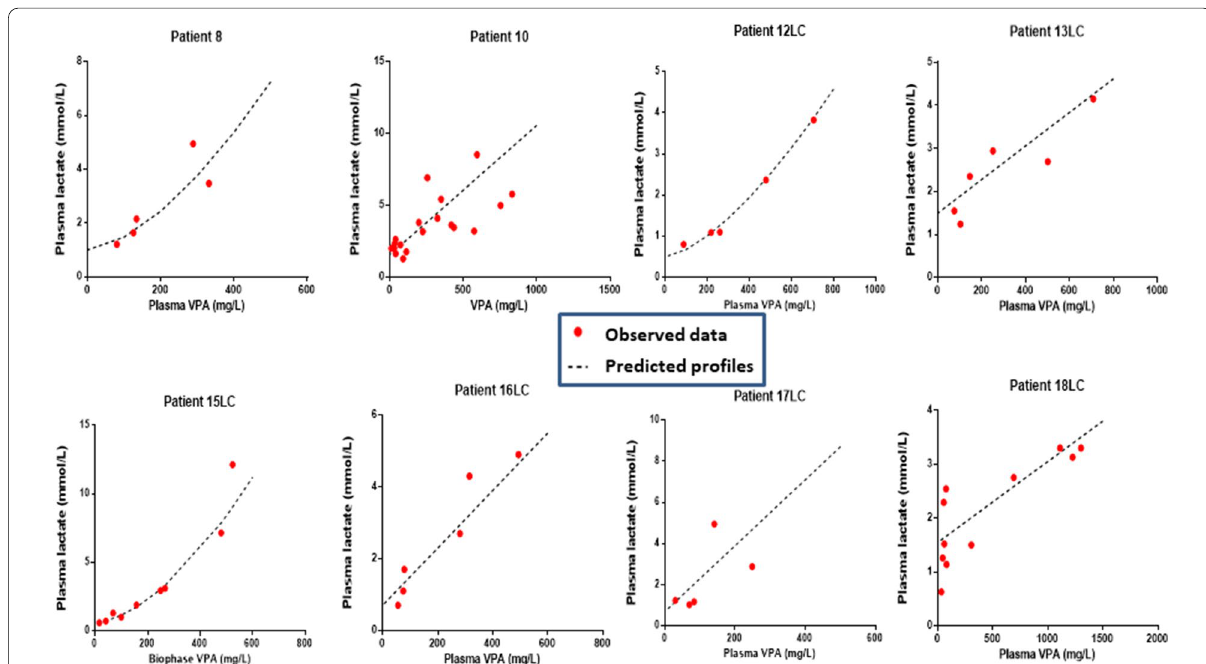
Fig. 3 Individual relationships between blood lactate and plasma valproic acid (VPA) concentrations in eight valproic acid-poisoned patients. LC means treated with L-carnitine